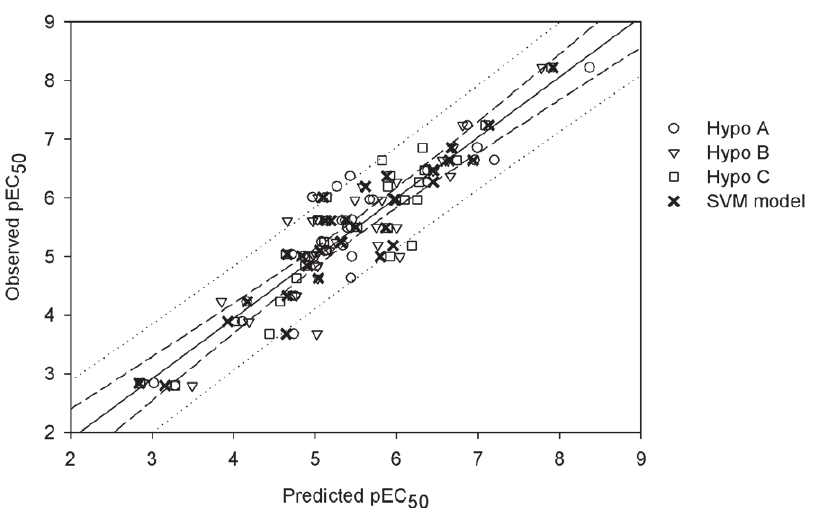
Figure 4. Observed vs. predicted pEC 50 values in the training set. Observed pEC 50 vs. the pEC 50 predicted by Hypo A, Hypo B, Hypo C and SVM model for those molecules in the training set. The solid line, dashed lines and dotted lines correspond to the SVM regression of the data, 95% confidence interval for the SVM regression and 95% confidence interval for the prediction, respectively.